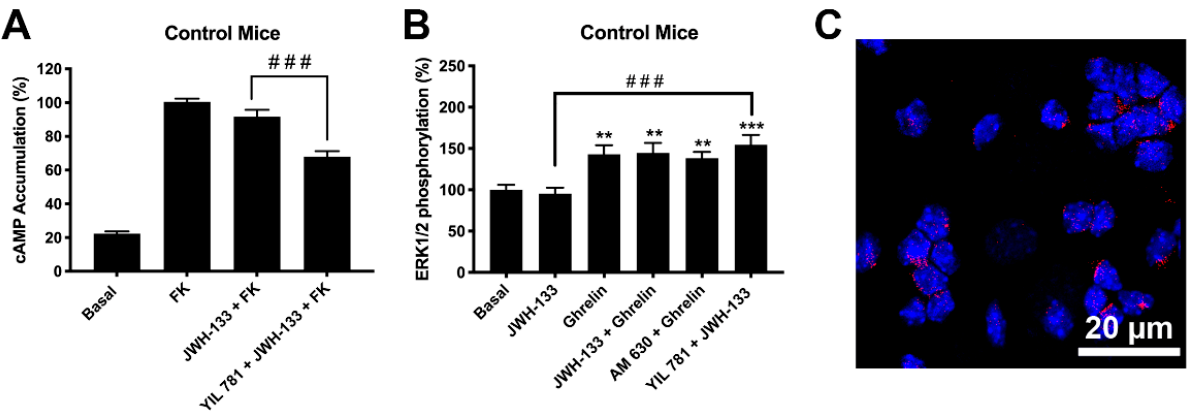
Figure 4. Expression and function of CB 2 R-GHSR1aHets in primary neurons from C57BL/6J mice. ( A , B ) Primary striatal neurons isolated from C57BL/6J mice were pre-treated with antagonists, 1 µM YIL 781 -for GHSR1a- or 1 µM AM 630 -for CB 2 R-, and subsequently stimulated with selective agonists, 200 nM ghrelin -for GHSR1a- or 200 nM JWH-133 -for CB 2 R-, individually or in combination. cAMP levels were determined using the Lance Ultra cAMP kit and results were expressed in % respect to levels obtained upon 0.5 µM forskolin stimulation ( A ), while ERK1/2 phosphorylation was analyzed using the AlphaScreen ® SureFire ® kit (PerkinElmer; Wellesley, MA, USA) ( B ). Values are the mean ± SEM of 6 different experiments performed in triplicates. One-way ANOVA followed by Dunnett’s multiple comparison post-hoc tests were used for statistical analysis. ** p <0.01, *** p < 0.001 versus basal, ### p < 0.001; versus JWH-133+FK treatment in cAMP or versus JWH-133 treatment in p-ERK1/2 assays. ( C ) CB 2 R-GHSR1aHets were detected in primary striatal neurons by the in situ proximity ligation assay (PLA) using specific antibodies. Cell nuclei was stained with Hoechst (blue). Samples from 5 different animals were processed and analyzed and quantitation is shown in Figure 5. Scale bar: 20 µ